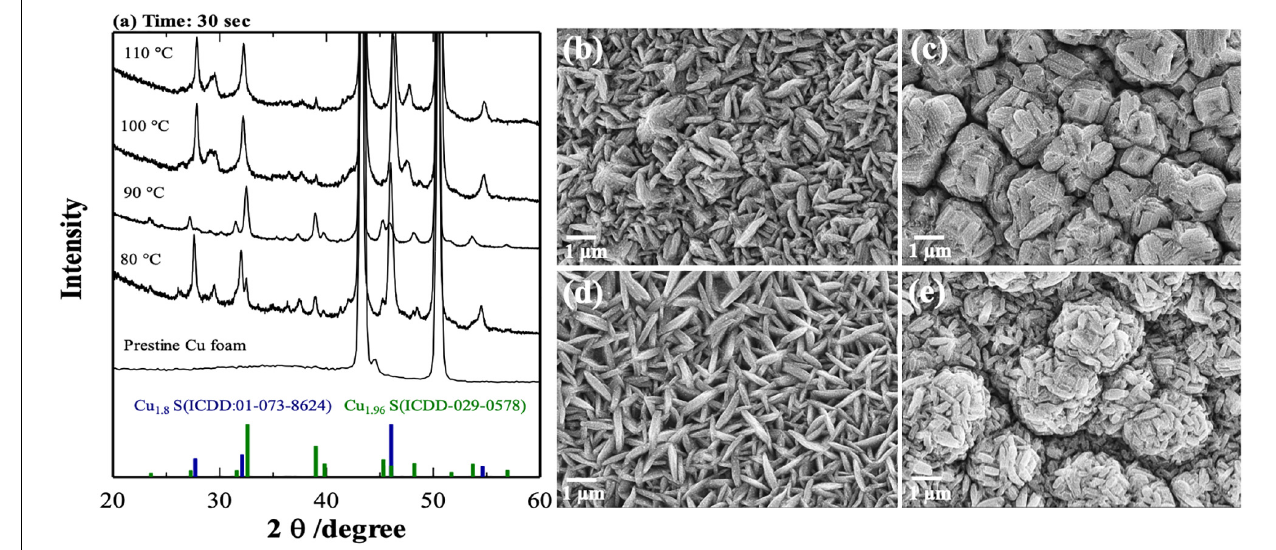
FIGURE 2 | X-ray powder diffraction patterns (a) and SEM pictures of Cu x S samples obtained at different temperatures with the constant time of 30 s: (b) 80 ◦ C, (c) 90 ◦ C, (d) 100 ◦ C, and (e) 110 ◦ C.